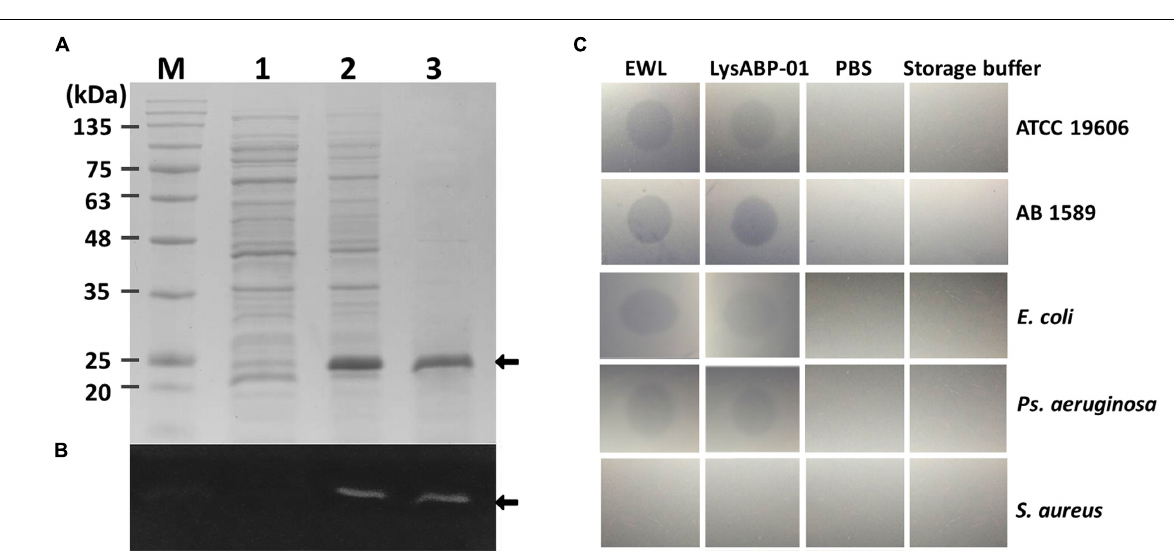
FIGURE 2 | Analysis of histidine-tagged LysABP-01. (A) SDS-PAGE analysis for expression and purification of LysABP-01. (B) Fluorescent stain for detection of His 6 -tagged LysABP-01 on a SDS-PAGE gel. Lane M, BLUeye prestained protein ladder; Lanes 1, un-induced bacterial lysate; Lane 2, IPTG-induced bacterial lysate; Lane 3, the purified Lys-ABP-01 after dialysis. (C) Plate lysis assay of the purified LysABP-01. Egg white lysozyme (EWL), A. baumannii ATCC19606